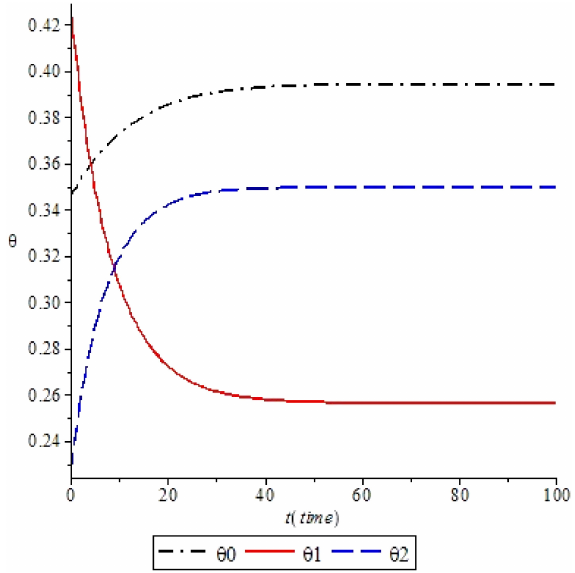
Fig. 4. Graphs of the optimal distribution of labor